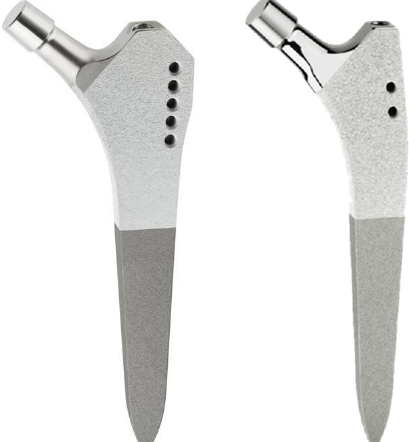
Figure 1. The SL-PLUS stem on the left side and the SL-PLUS MIA stem on the right side. Both stem designs are based on the Zweymüller concept with a proximal hydroxyapatite coating in order to facilitate bone ingrowth. For the SL-PLUS MIA stem the metaphyseal geometry was modified with a less prominent lateral shoulder in order to facilitate a bone preserving implantation.